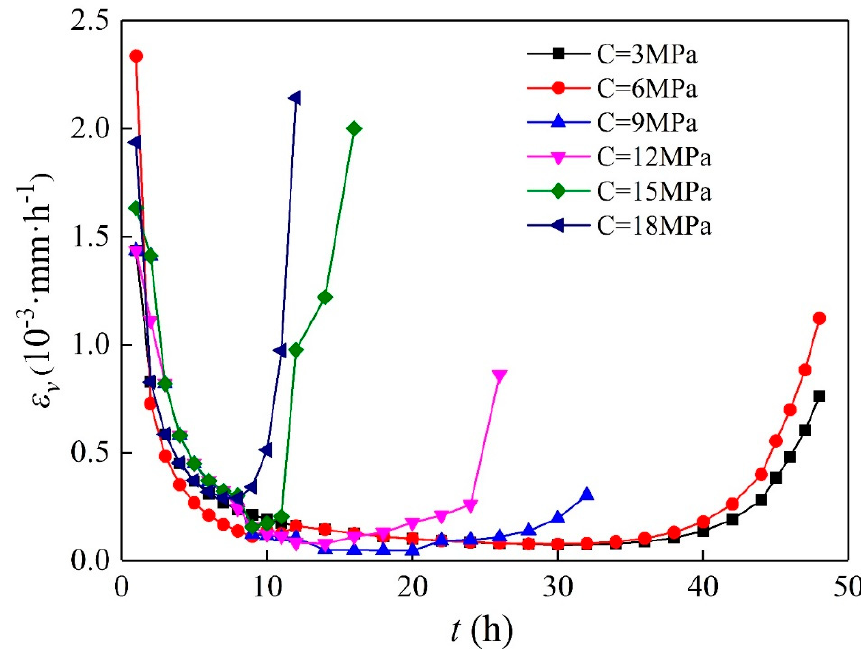
Figure 5. Creep deformation rate of AS samples under different confining pressures.